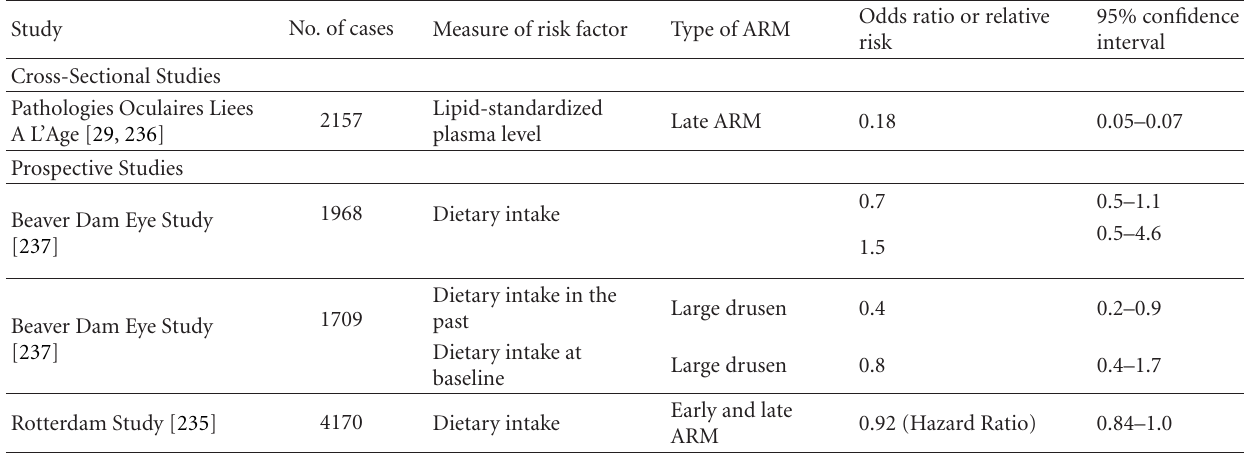
Table 10: Studies investigating the relationship between vitamin E and risk for